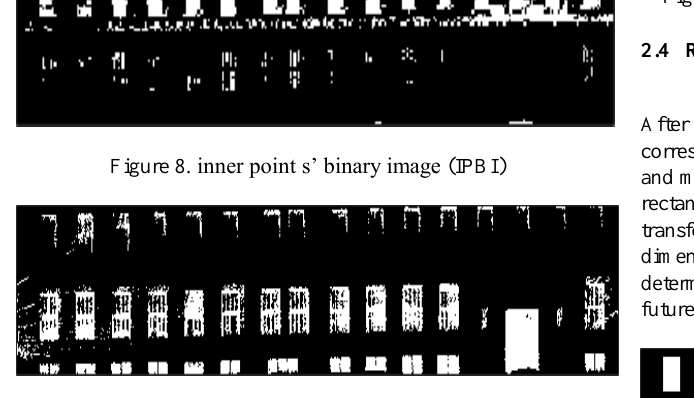
Figure 9. façade point s’ binary image (FPBI)